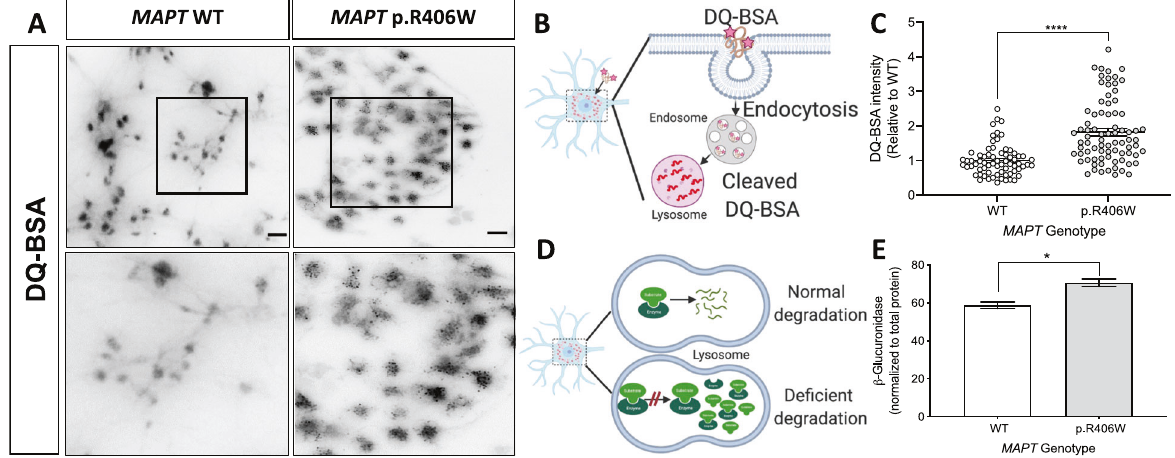
Fig. 5 Lysosomal dysfunction in human iPSC-neurons expressing the MAPT p.R406W mutation. Human iPSC-neurons neurons from a MAPT p.R406W mutation carrier and isogenic, CRISPR/Cas9-corrected control (wild-type (WT)) were differentiated into cortical neurons and cultured for 6 weeks prior to analysis. A MAPT p.R406W neurons exhibit increased DQ-BSA fl uorescence. Live cells were incubated with DQ-BSA and were imaged as described in Methods. Representative images of DQ-BSA-stained neurons are shown in gray scale for clarity. Scale bar, 10 microns. Lower panel represents magni fi cation of the cells in the black box. B Diagram of DQ-BSA mechanism. C Quanti fi cation of the intensity of DQ-BSA staining in soma from MAPT p.R406W neurons ( n = 79 cells) and isogenic controls ( n = 69 cells). D Diagram of secondary elevation of lysosomal enzymes. E Enzyme activity of β -Glucuronidase measured in cell lysates from MAPT p.R406W neurons and isogenic controls. Enzymatic activity was normalized to the total protein. Graphs represent mean ± SEM. Signi fi cance was determined using an unpaired, t -test. * p < 0.05; **** p < 0.0001. brains expressing the MAPT p.R406W mutation and that the MAPT tau isoform, which may produce effects that are a function of p.R406W is suf fi cient to induce these changes in human neurons protein overexpression and possible off-target effects rather than and cerebral organoids, leading to altered lysosomal function. a disease-relevant phenotype. Thus, our understanding of how tau Finally, we show that treatment with mTORC1 and mTORC2 is metabolized in the human brain has been obtained from inhibitors reduce tau levels speci fi cally in MAPT p.R406W neurons. experimental paradigms that do not fully capture physiological FTLD-tau caused by MAPT p.R406W results in an overall defect conditions relevant to human tauopathies. Here, we show that in lysosomal machinery. TFEB, which is the master regulator of lysosomal biogenesis, autophagosome machinery, and down- lysosomal function, was found to be elevated in the FTLD-tau stream protein degradation pathways are disrupted in FTLD-tau